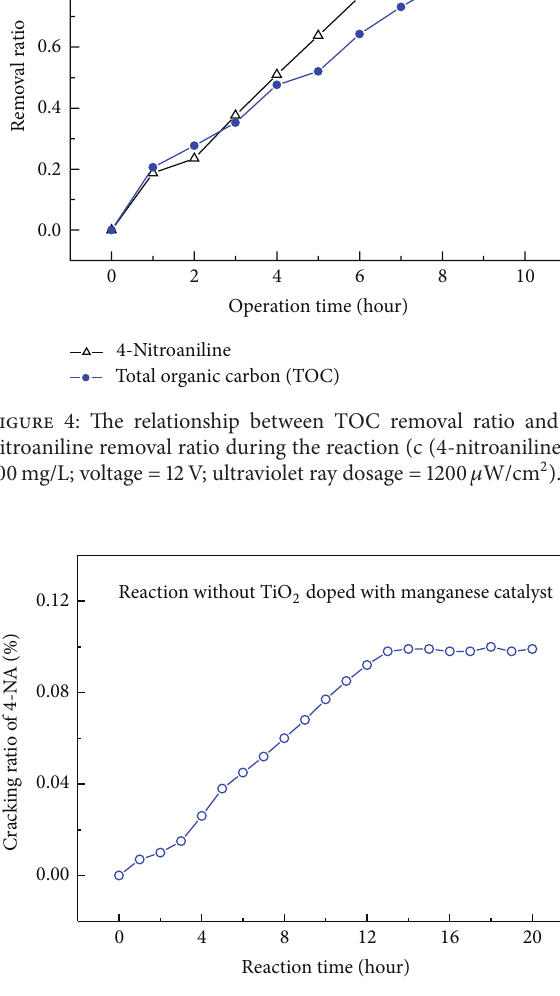
Figure 5: The relationship between cracking ratio of 4-nitroaniline ring and operation time during reaction (c (4-nitroaniline) = 100mg/L; voltage = 12 V; ultraviolet ray dosage = 1200 𝜇 W/cm 2 ).